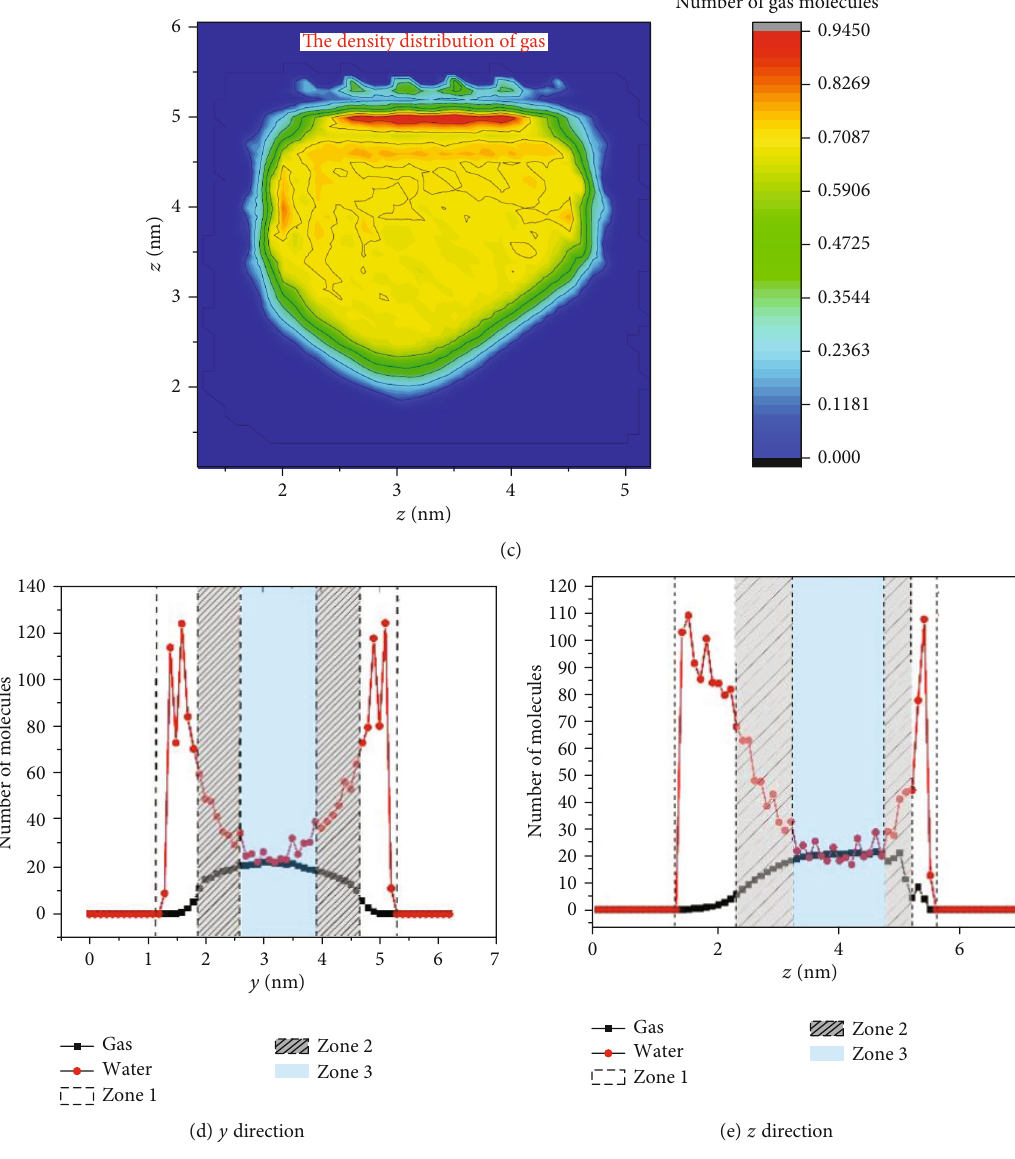
Figure 2: The elevation of water and gas at equilibrium in a pore, the density 2D distribution of gas and water molecules, and an average density distribution curve of gas and water in the yz plane under a static equilibrium state of equilibrium molecular dynamics [24]. (a) The elevation of water and gas at equilibrium in a pore. The gray ball represents the carbon atoms in the methane molecule, which can represent gas molecules. The green ball represents the oxygen atoms in the water molecule, which can represent water molecules. (b) The density 2D distribution of gas. (c) The density 2D distribution of water. (d) The density distribution curve of water and gas molecules along the y direction, and (e) is the density distribution curve of water and gas along the z direction. The shaded areas are estimated to be highly interactive between the gas and water